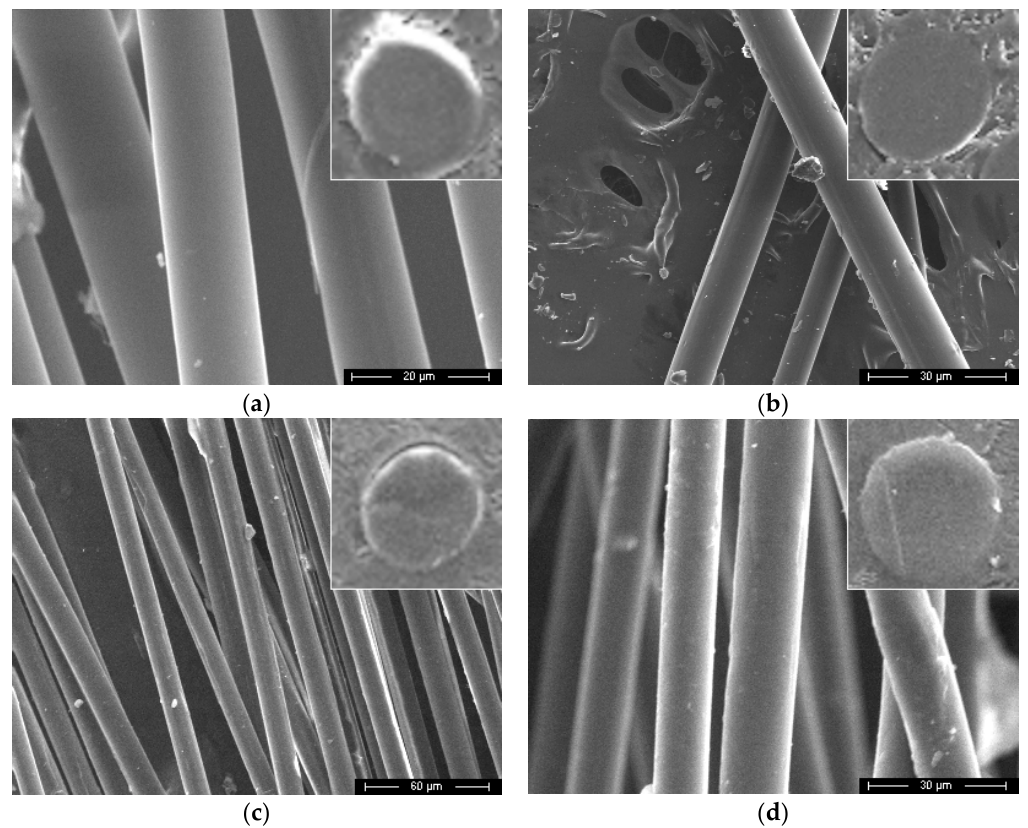
Figure 2. Microphotographs of surface and cross-section of cellulose ( a ), composite precursors 95% cellulose + 5% BTMSA ( b ), 90% cellulose + 10% VTEOS ( c ), 95% cellulose + 5% BTMSA ( d ).